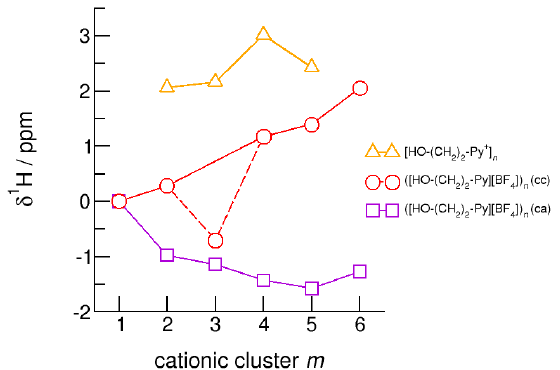
Figure 14. Average NMR proton chemical shifts, δ 1 H, of the hydroxyl protons for the cationic clusters [HO-(CH 2 ) 2 -Py + ] n (triangles), ([HO-(CH 2 ) 2 -Py][BF 4 ]) n (c–c) (circles) and ([HO-(CH 2 ) 2 -Py][BF 4 ]) n (c–a) (squares) related to the corresponding monomer values calculated at the B3LYP-D3/6–31+G* level of theory.